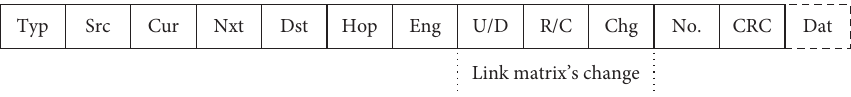
Figure 1: Format of the data frame. ACK frame does not include the Dat segment.